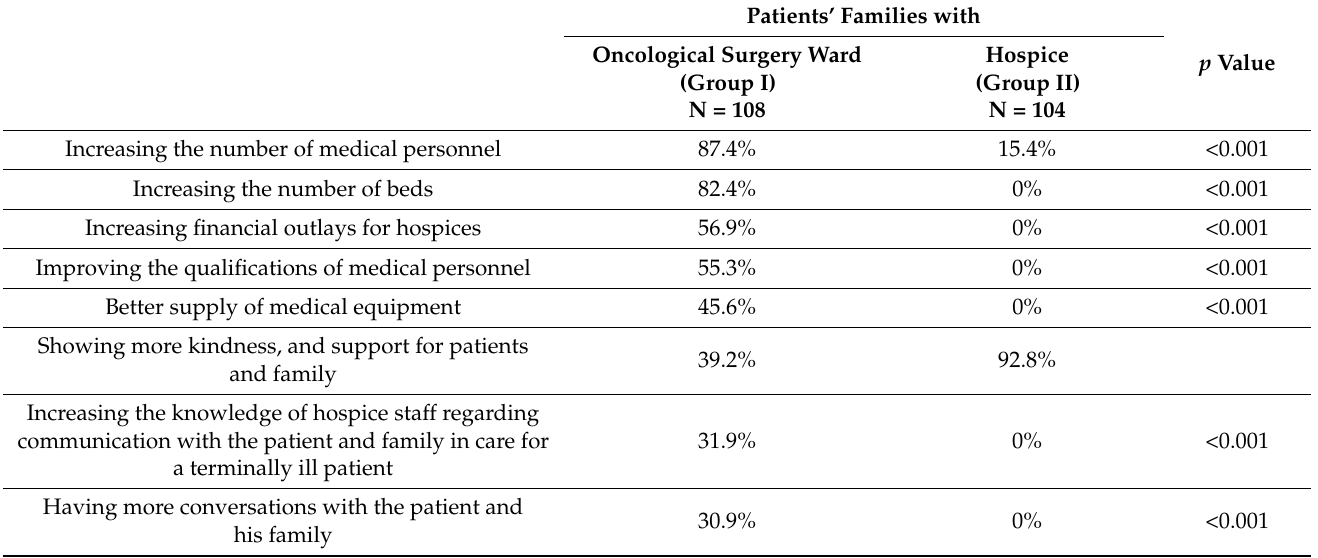
Table 14. Opinions on how to improve patient care at the end of life *. Patients’ Families